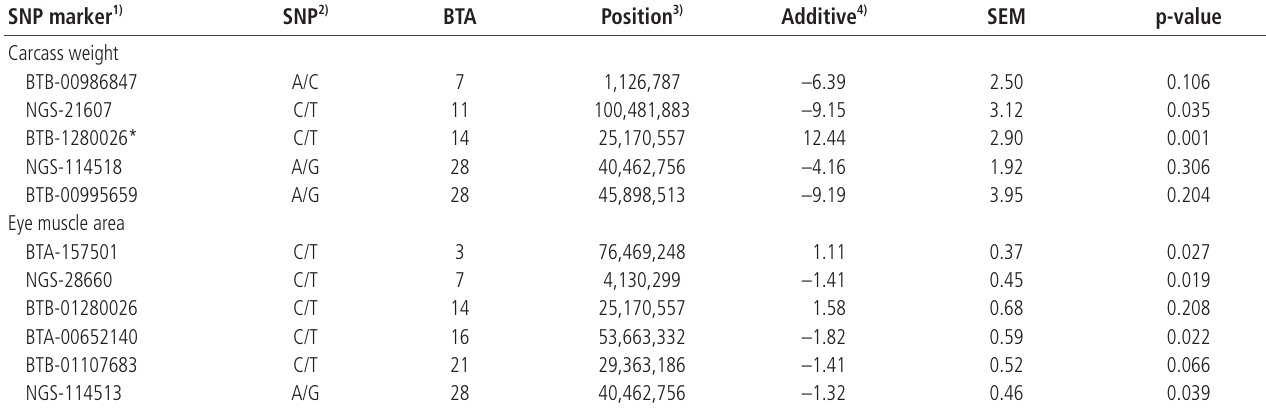
Table 7. Identities, positions, and effect of the SNPs on carcass weight and eye muscle area of Hanwoo